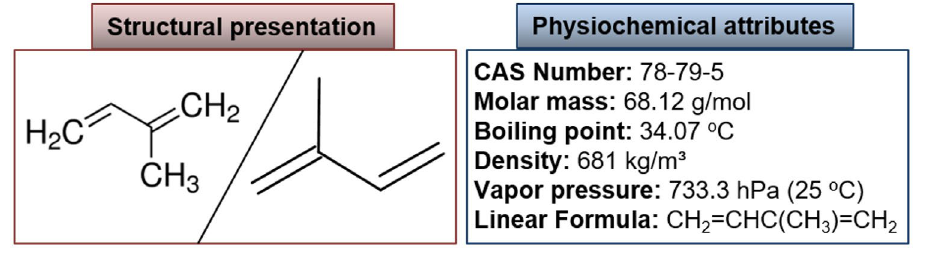
Fig. 4. Structural and physiochemical attributes of